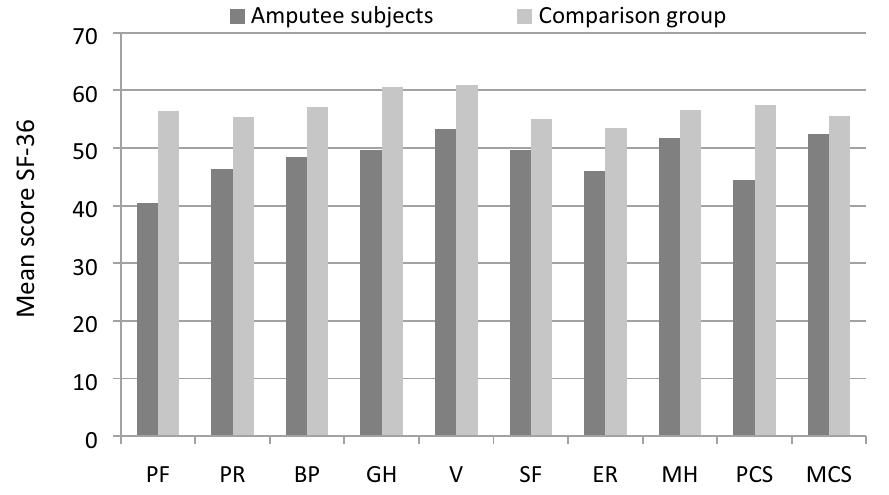
Figure 1. Questionnaire SF36 (mean ± SD).